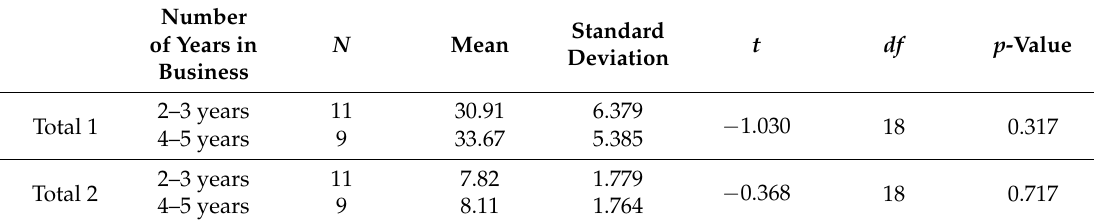
Table 6. Number of years in business.